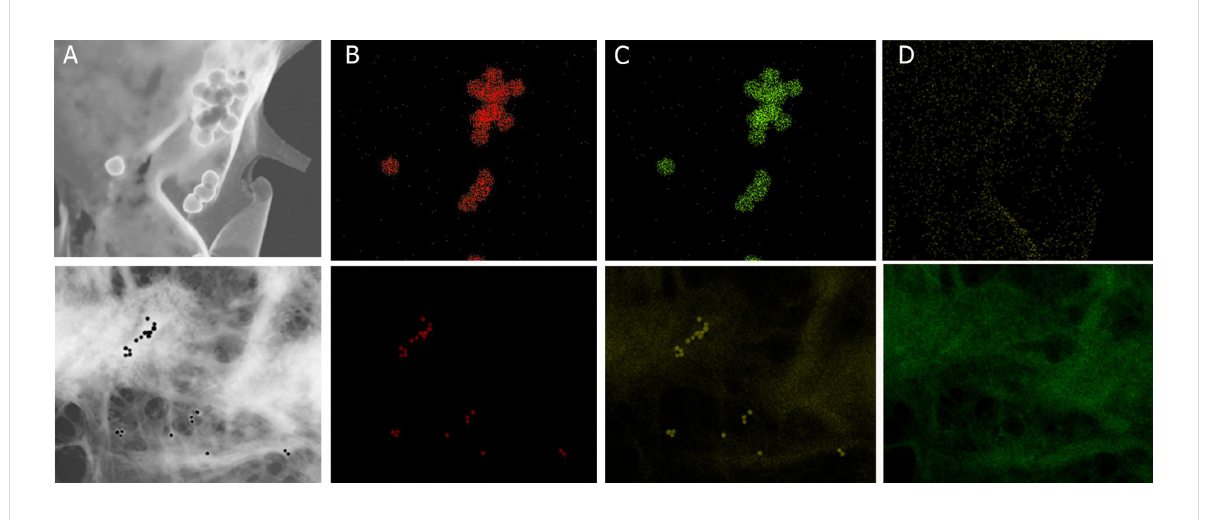
Figure 5: (A) High-resolution TEM image of Antibody-PEG5000Au CPMV; (B) elemental EDX map of gold; the signal is distributed almost uniformly on the same position as the electron-dense particles in (A); (C) sulfur from the linker attachment to the nanoparticles distributed uniformly on the same